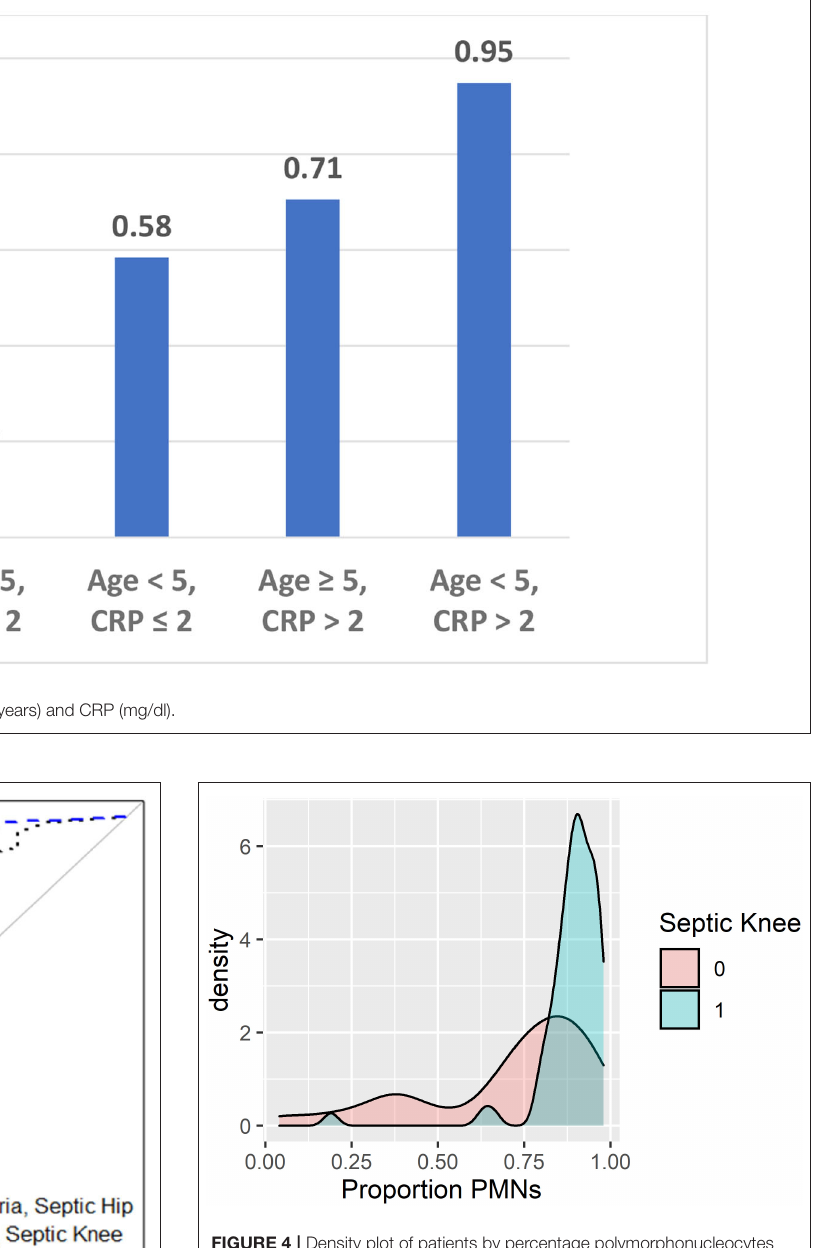
FIGURE 4 | Density plot of patients by percentage polymorphonucleocytes (%PMN) for known septic knee vs. aseptic